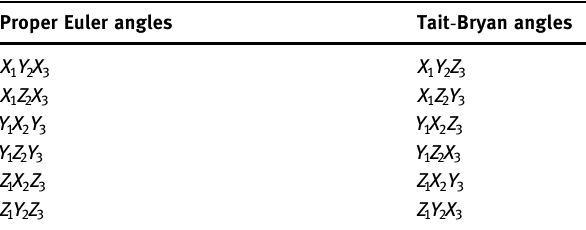
Table 2: Possible rotation sequences Proper Euler angles Tait - Bryan